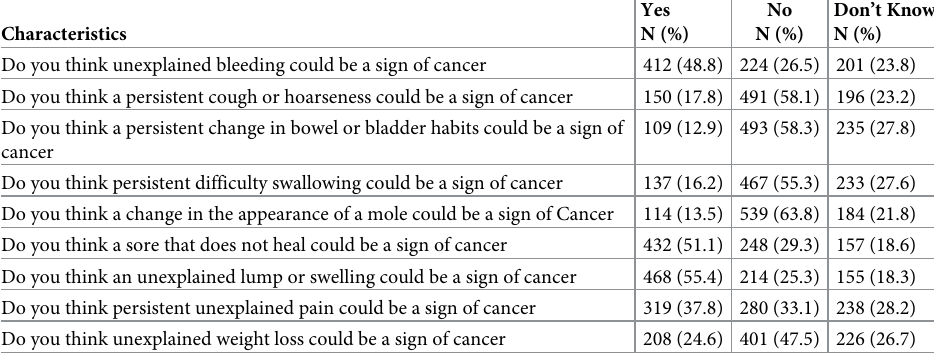
Table 2. Knowledge about the early warning signs of cancer, Bahir Dar city residents, North West Ethiopia, 2019 (n =